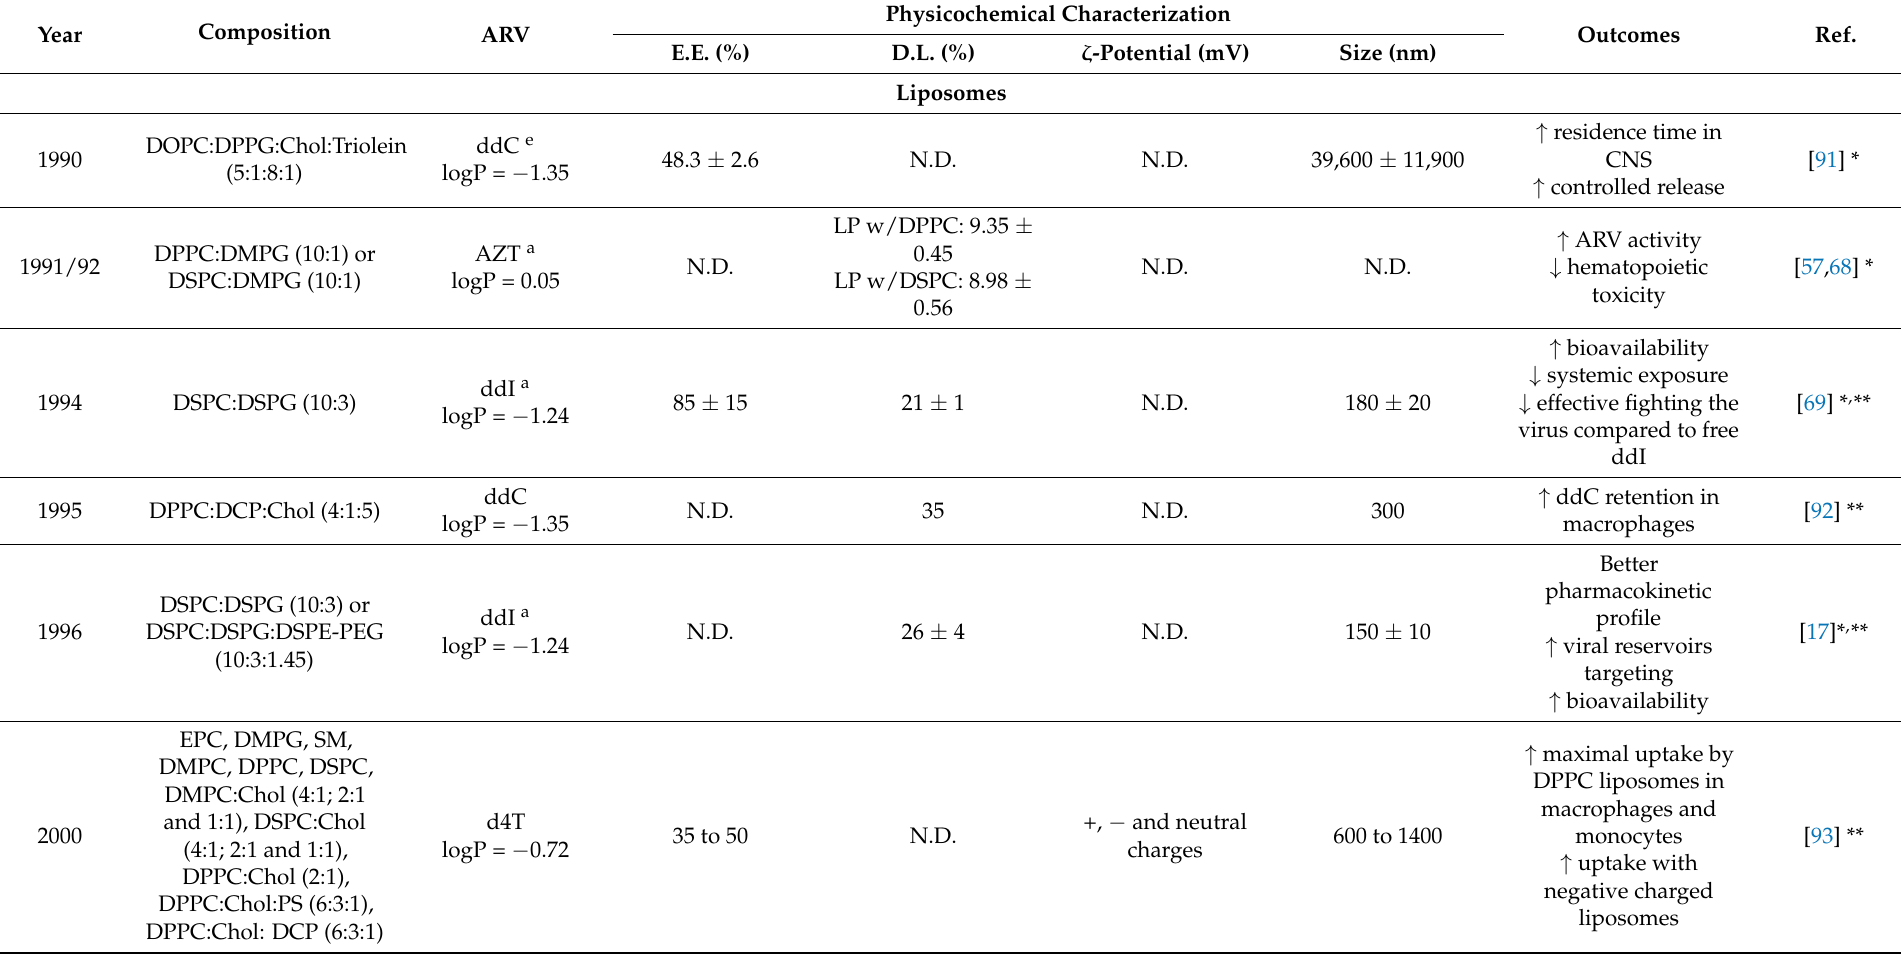
Table 3. Liposomes, ethosomes, cubosomes, and hybrid liposomal nanocarriers for ARV